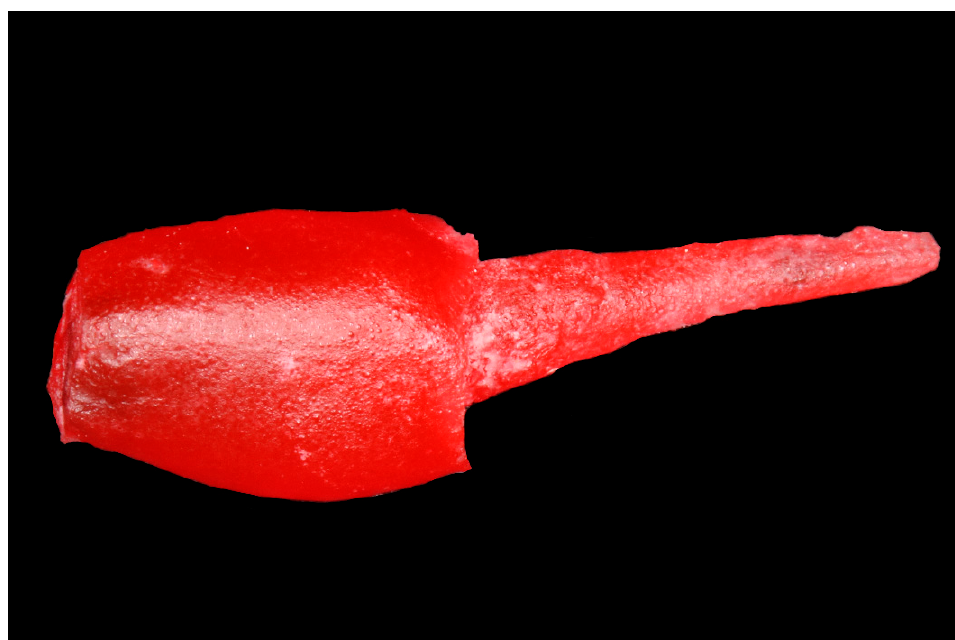
Figure 3. Pattern resin post-and-core build-up.